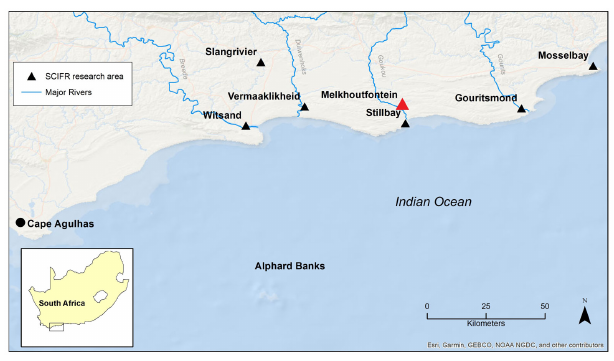
Fig. 2 . Map of the southern Cape (adapted from Gammage